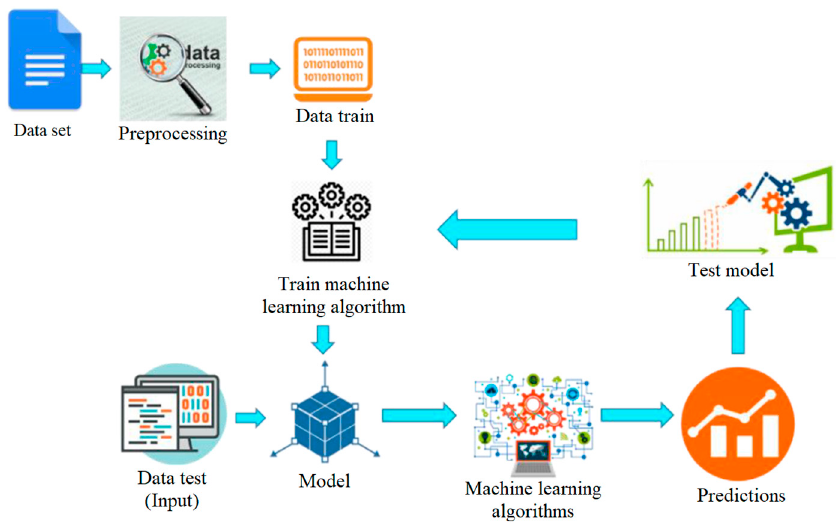
Figure 3. Working steps of the machine learning predictive (MLP) model.